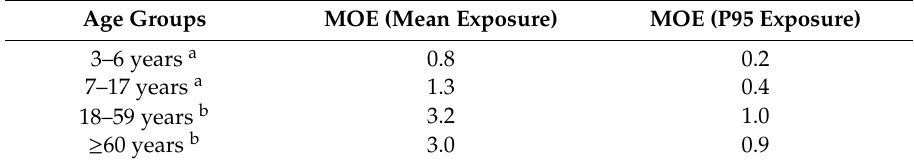
Table 4. Summary of margin of exposure (MOE) by age group in Guangzhou city.